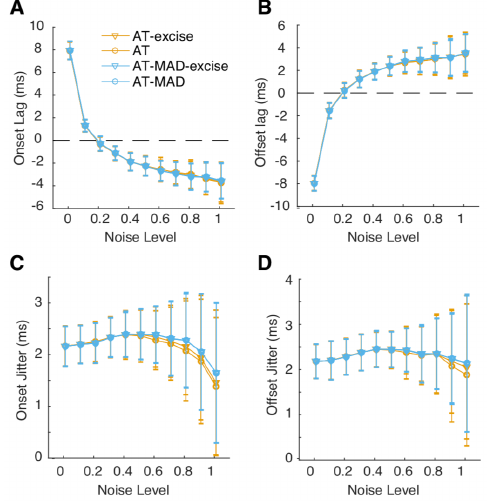
Figure 3. Onset and offset lags are comparable across all algorithms (A- B) Mean and standard error of the onset (A) and offset (B) lags, which is the difference in onset/offset as determined by the algorithm and the reference. All tested algorithms show similar lags. At higher noise levels, the lag decreases (shifted earlier). (C-D) Mean and standard deviation of the onset (C) and offset (D) jitter in lag. Across all tested noise levels, jitter is around 2 ms, but variability in jitter gets higher with increasing noise levels. Jitter at all noise levels is comparable across